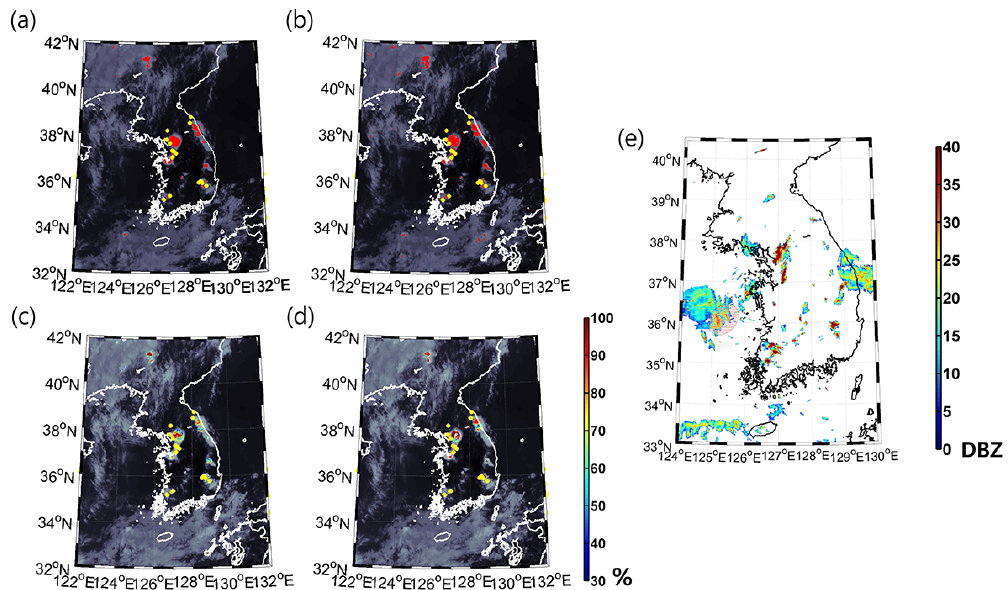
Figure 9. Deterministic CI detection map derived by DT, RF, probabilistic RF, and LR on 7 August 2015 at 07:30 (UTC): (a) DT, (b) RF, (c) Prob RF, and (d) LR 30min before CI occurrence. Panel (e) is the 1.5km radar CAPPI image at 08:00 (UTC). While predicted CI is in red, the locations of lightning occurrences at 08:00 (UTC) are presented in yellow dots. The radar echoes above 35dBZ beyond the effective radius of radar are shaded with red hatching.